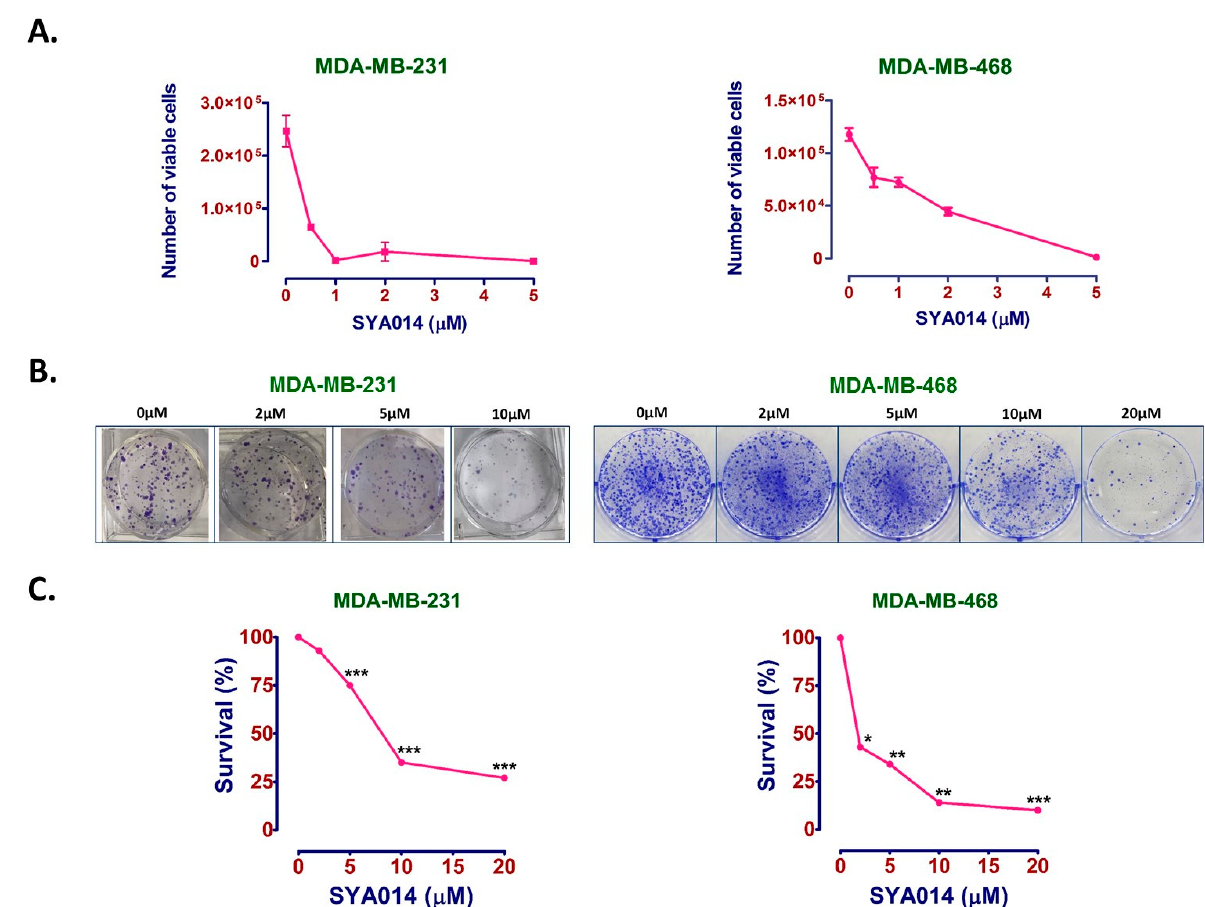
Figure 2. SYA014 inhibits cell proliferation and colony formation of TNBC cell lines. SYA014 inhibits the proliferation of ( A ) MDA-MB-231 cells and MDA-MB-468 cells. The compound also inhibits colony formation of both MDA-MB-231 and MDA-MB-468 cells lines. Representative images